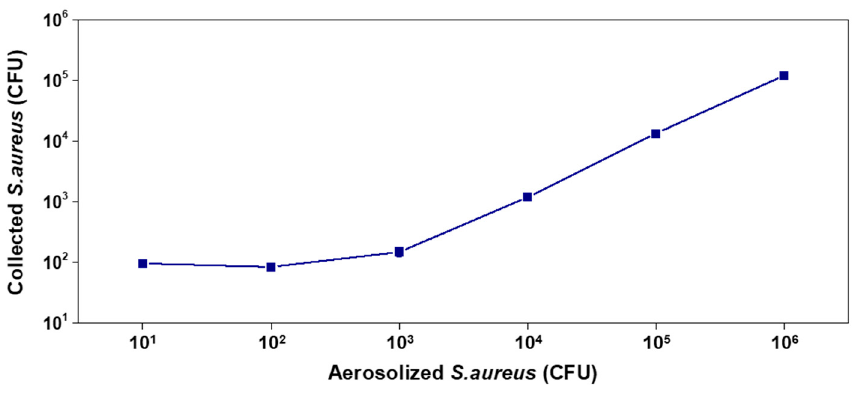
Figure 4. Detection result of collected S. aureus using the cabinet system with bacterial aerosol spiking.